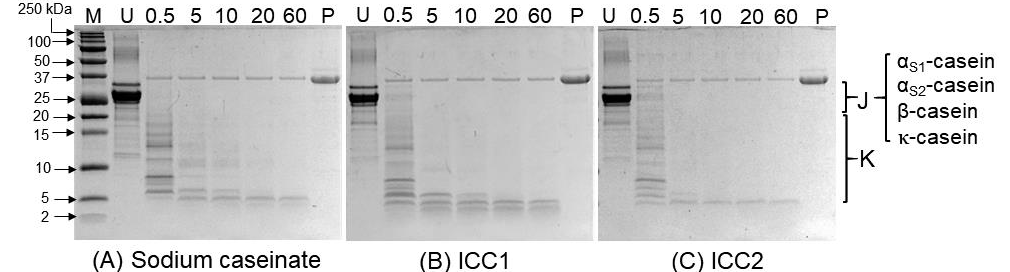
Figure 2. Digestibilities of ( A ) sodium caseinate and ( B , C ) iron-casein complexes 1 and 2 (i.e., ICC1 and ICC2 , respectively) under simulated in vitro gastric digestion over time (i.e., 0.5, 5, 10, 20 and 60 min). Samples were reconstituted in water (1%, w / v ) and subjected to in vitro static gastric digestion at pH 2 and 37 ◦ C using pepsin (2000 U / mL). M, molecular weight marker; U, undigested sample; P, pepsin only.